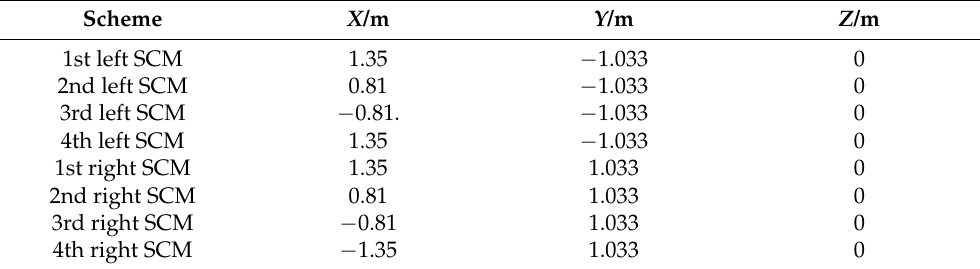
Table 2. Location of SCMs